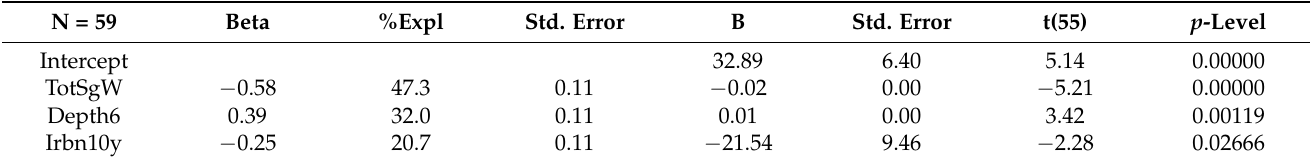
Table 4. Results from statistical regression, cases without coral protection, with TotSgW as the total width of seagrass meadows in meter, Depth6 as the minimum distance where a six meters water depth is recorded and Irbn10y as the Iribarren number (Komar, 1998) calculated for a 10 year return period. N = 59 Beta %Expl Std. Error B Std. Error t(55) p -Level Intercept